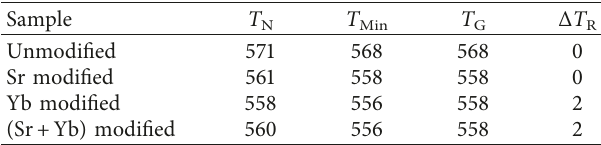
Figure 2: Cooling curves measured from the melts with different additions of modifiers, for all tested different rare elements addition to the Al-7 wt.%Si alloy with corresponding optical micrographs of representative eutectic structure in each sample. Table 2: Nucleation ( T N ), minimum ( T Min ), and growth tem- peratures ( T G ) and eutectic recalescence for samples with addition of different elements.